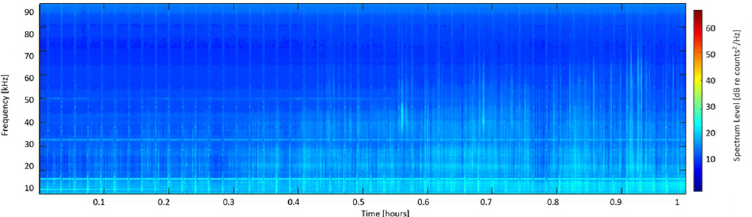
Fig 5. Long-term spectral average of an LF1 encounter. Long-term spectral average of data from 11/13/2015 including clicks labelled as type LF1. A sighting of rough-toothed dolphins occurred about 1 hour after this encounter, approximately 5 km from the location of the